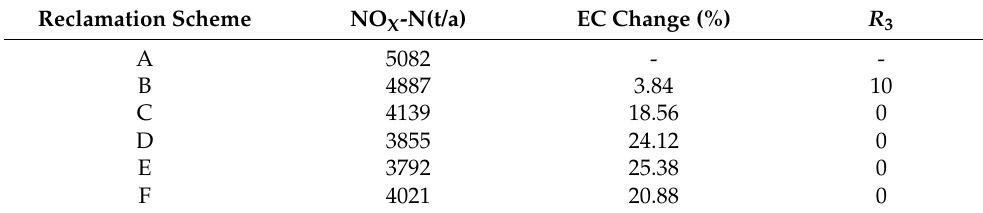
Table 7. Feasibility evaluation in NO X -N environmental capacity.